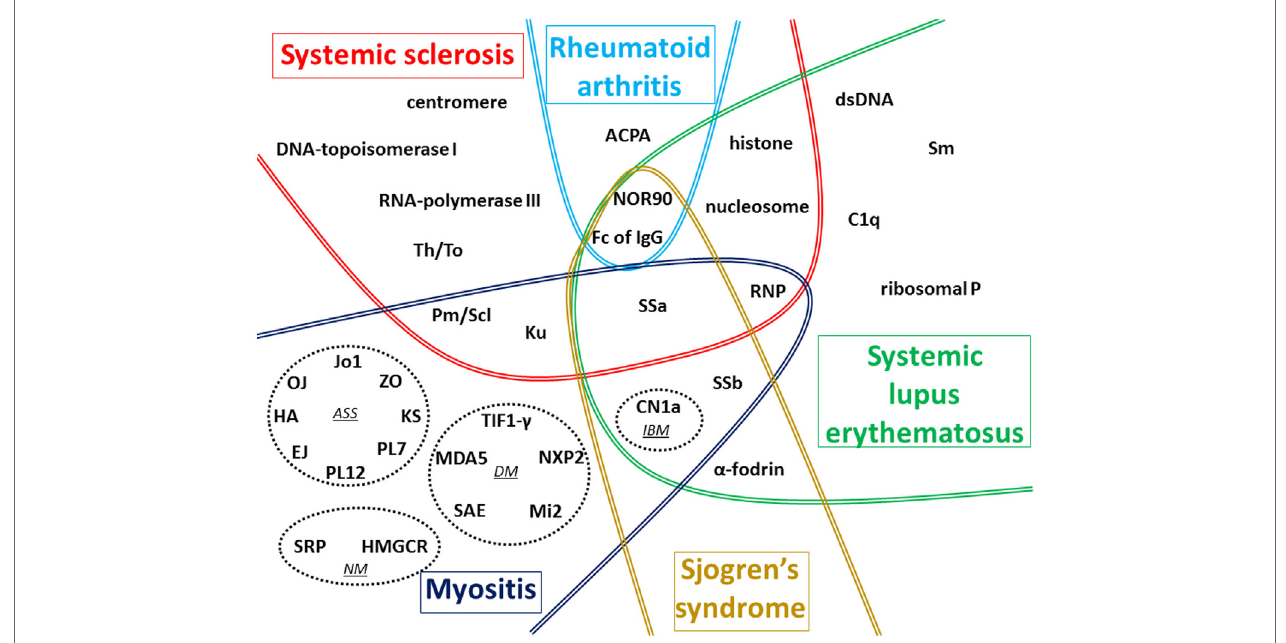
FiGURe 1 | Global vision of autoantigens targeted by autoantibody (AAb) according to the type of connective tissue diseases (CTDs). The main targets of AAb associated with the five CTDs detailed in this review are recapitulated on this figure. In myositis, four distinct forms associated with distinct AAbs are represented in dotted circles: antisynthetase syndrome (ASS), dermatomyositis (DM), necrotizing myopathy (NM), and inclusion body myositis (IBM). In systemic sclerosis (SSc), most AAbs are preferentially associated with one of the two cutaneous forms described: anti-centromere, anti-Th/To, anti-Pm/Scl, anti-Ku, and anti-U1-RNP AAbs are generally associated with limited form of SSc whereas anti-DNA-topoisomerase I, anti-RNA-polymerase III, and anti-U3-RNP AAbs are mostly associated with diffuse cutaneous SSc. The term ACPA regroups anti-cyclic citrullinated peptide and also anti-non-cyclic citrullinated peptides AAb. Fc of IgG corresponds to target of rheumatoid factor. Some AAbs are associated with more than one CTD as shown in the different overlap areas on the